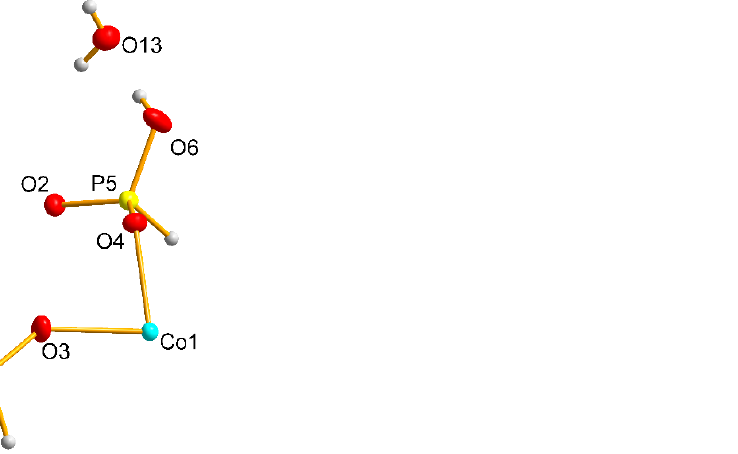
Figure 1. Asymmetric unit of (H 2 DAB)[Co(H 2 PO 3 ) 4 ] · 2H 2 O. Thermal ellipsoids are shown at 60% probability.